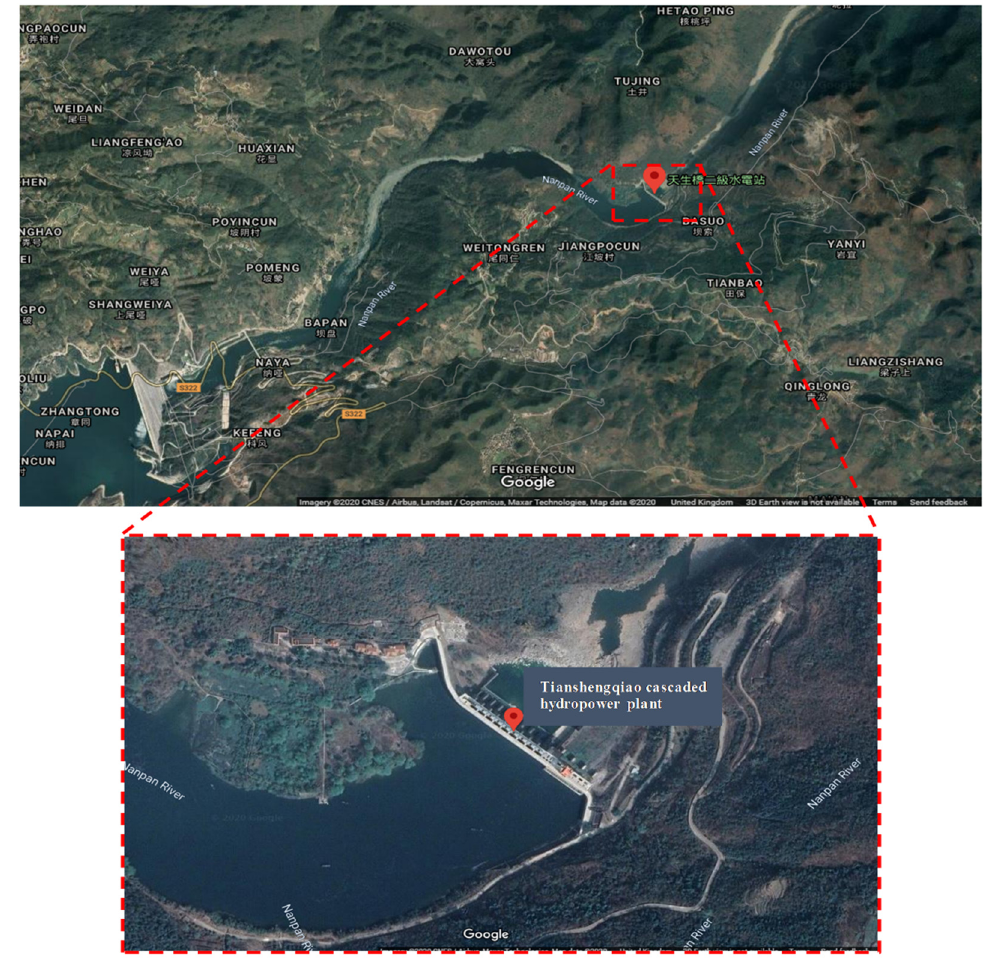
Figure 1. Satellite image of the Tianshengqiao cascaded hydropower plants (by Google maps).